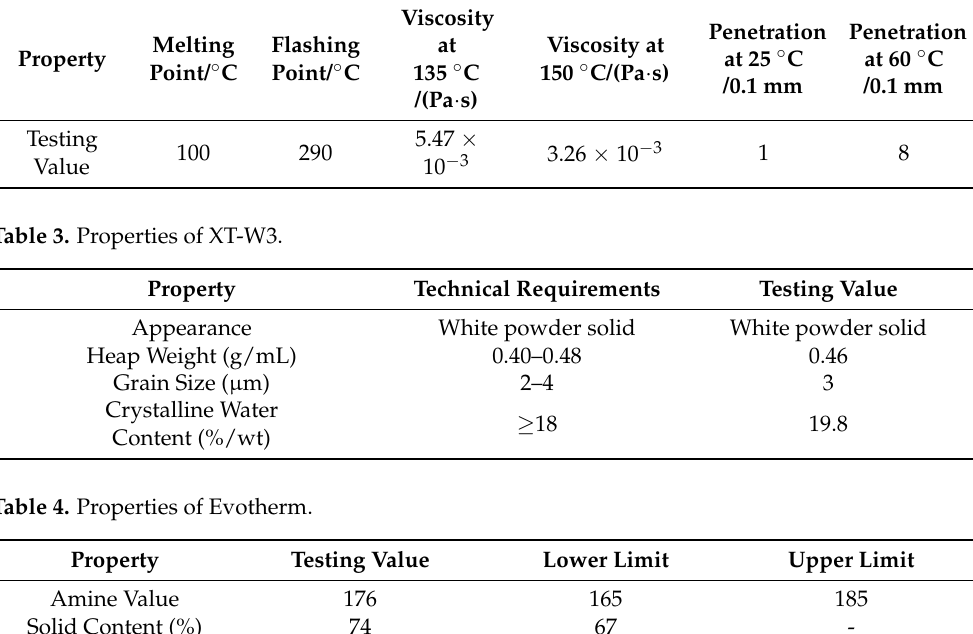
Table 2. Properties of Sasobit.